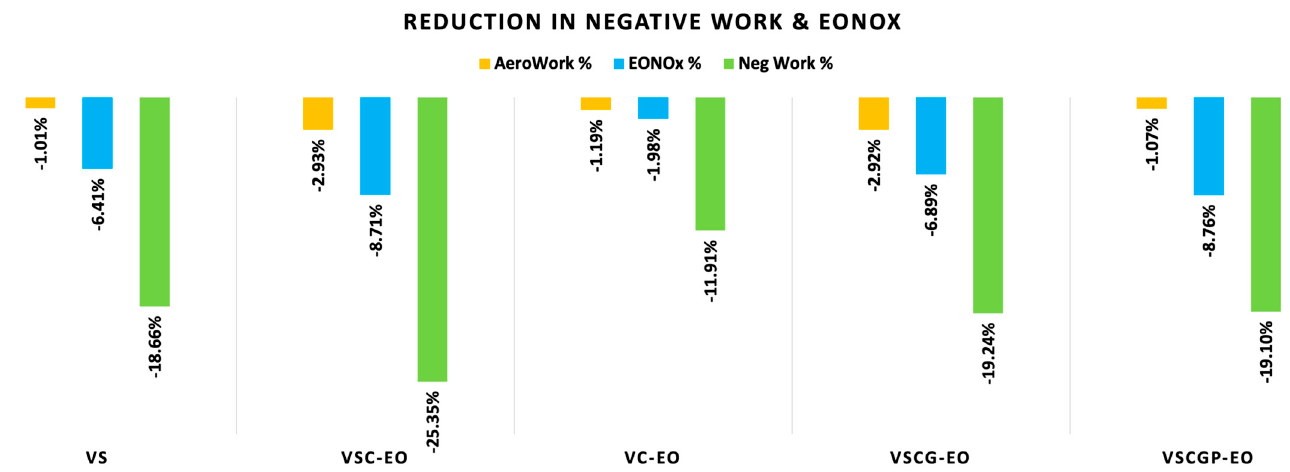
Figure 11. Reduction in aerodynamic work along with associated EONOx reduction. The last bar plot shows the reduction in negative work which includes engine braking, motoring losses and service braking.